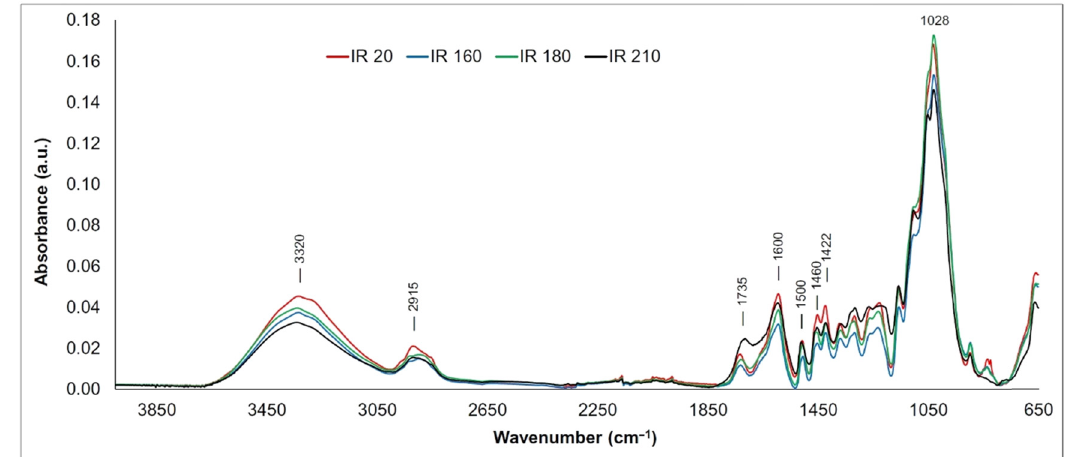
Figure 2: FTIR spectra of the thermally treated iroko